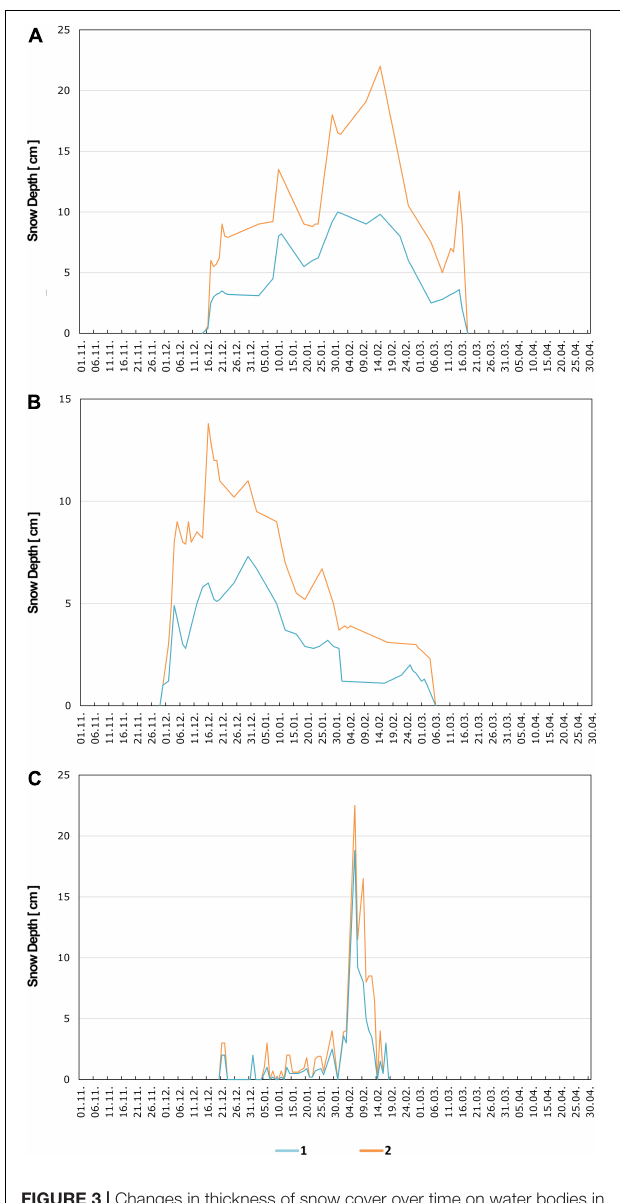
FIGURE 3 | Changes in thickness of snow cover over time on water bodies in the Silesian Upland in the (A) first, (B) second, and (C) third winter season: 1–average snow depth, 2–maximum snow